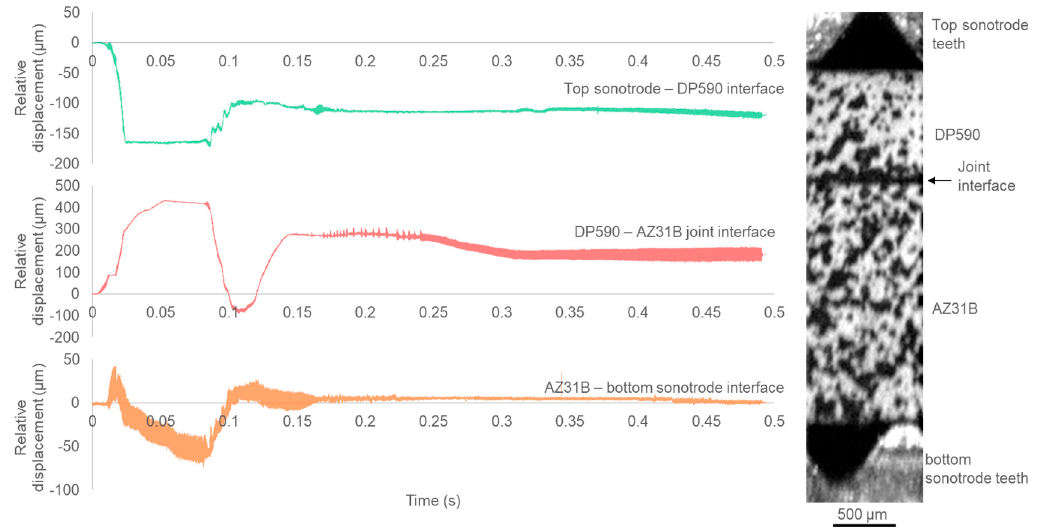
Figure 1 . Relative displacement curves across each interface measured at different time frames. Figure 1. Relative displacement curves across each interface measured at di ff erent time frames.